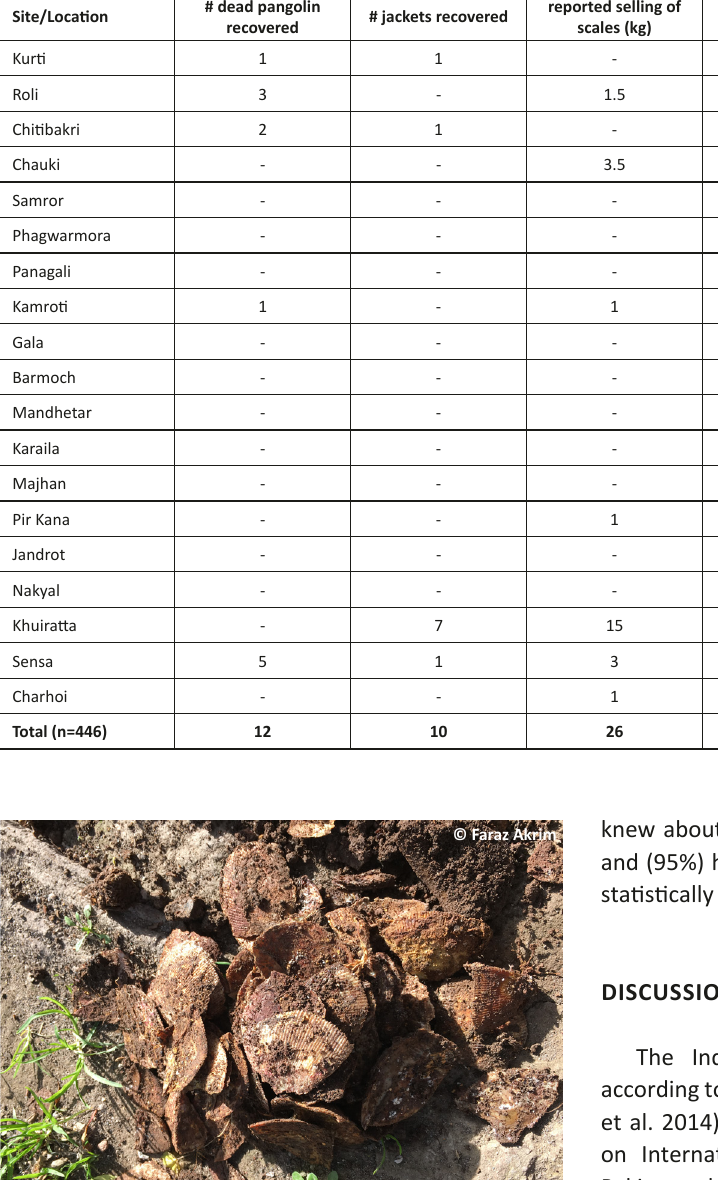
Table 2. Massive illegal killing and capture record of Indian Pangolin Manis crassicaudata in district Kotli, Azad Jammu & Kashmir, Pakistan from 2013–2015.